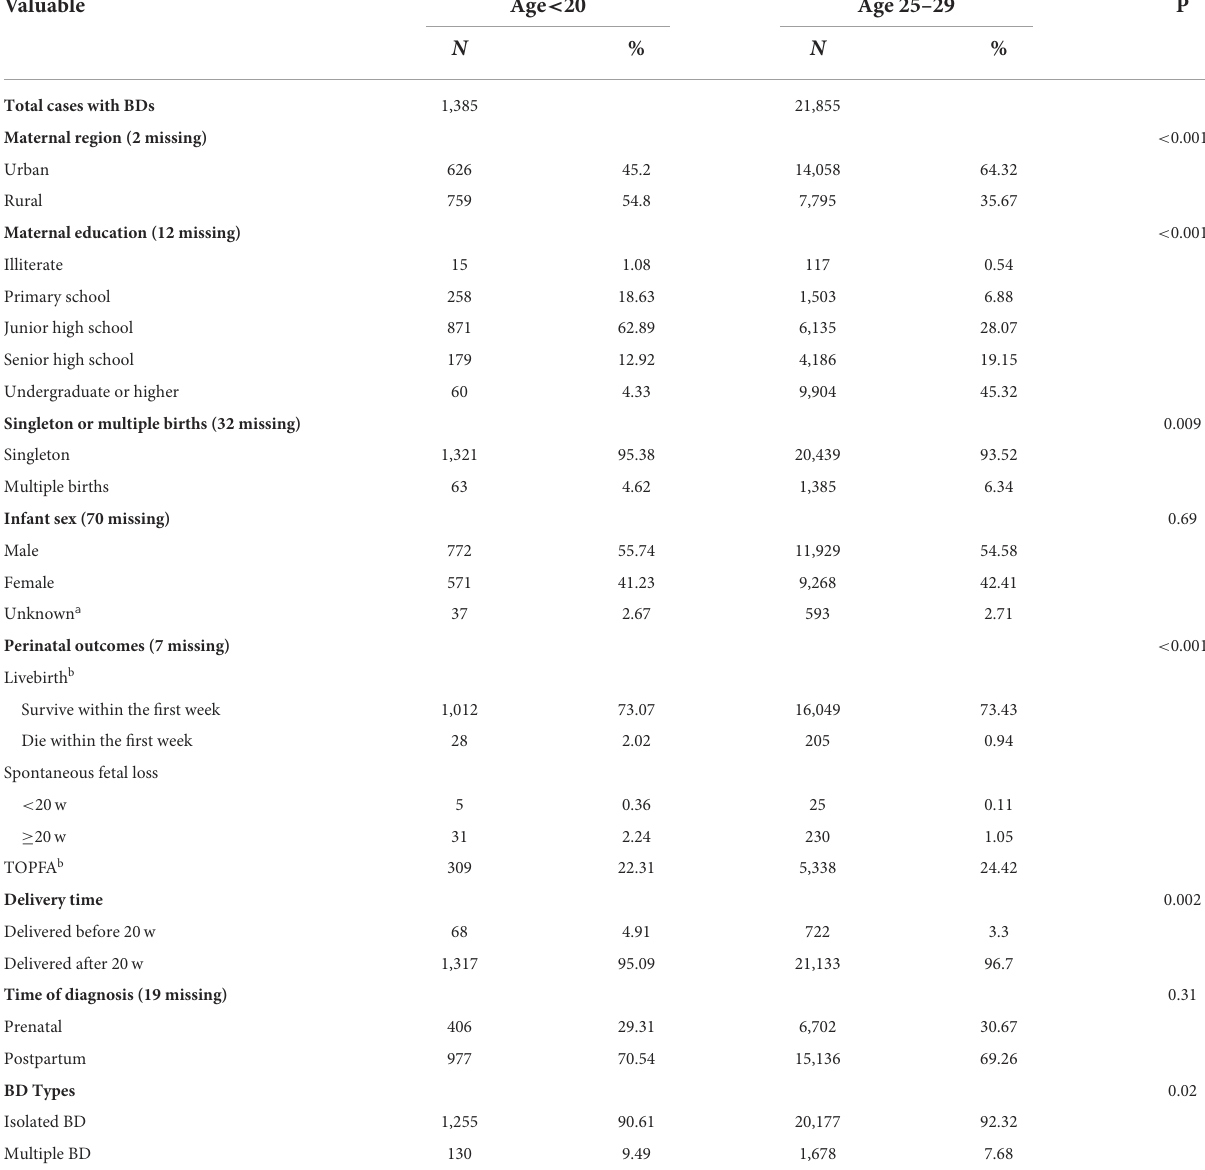
TABLE 1 Maternal and their offspring’s characteristics of total births with birth defects according to maternal age. Valuable